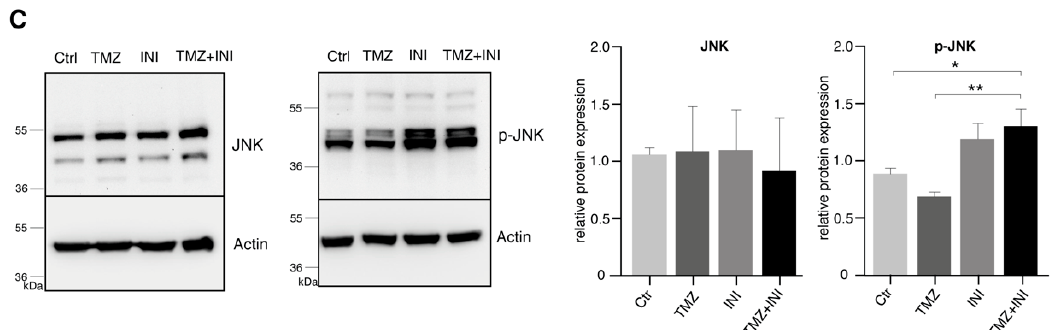
Figure 6. Additional gap junction inhibition leads to elevated activation of the JNK signaling pathway.